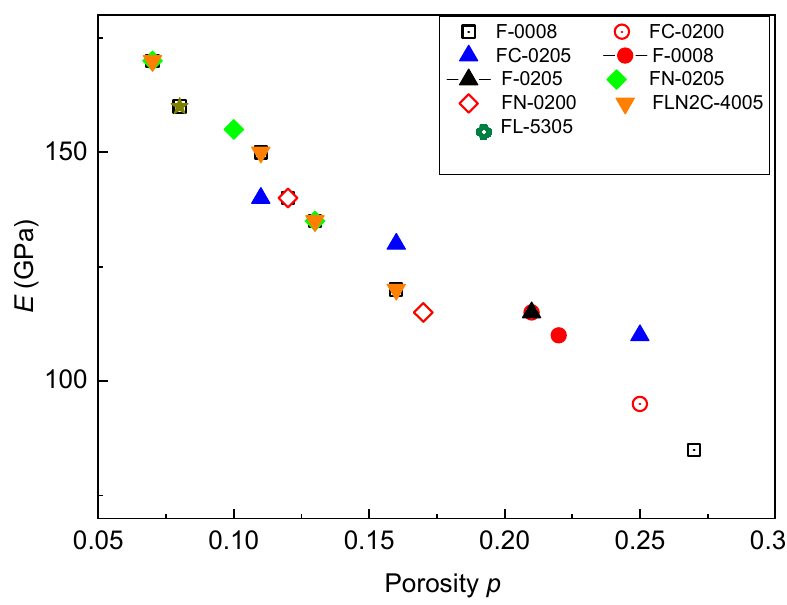
Figure 6. Elastic modulus vs. porosity redrawn from ref. [14].